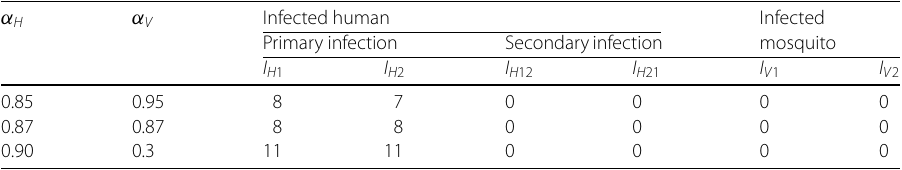
Table 6 Effect of α H and α V on the number of infected populations: I H 1 , I H 2 , I H 12 , I H 21 , I V 1 , and I V 2 at steady state using the multi-serotype dengue model (2.4)–(2.5) α H α V Infected